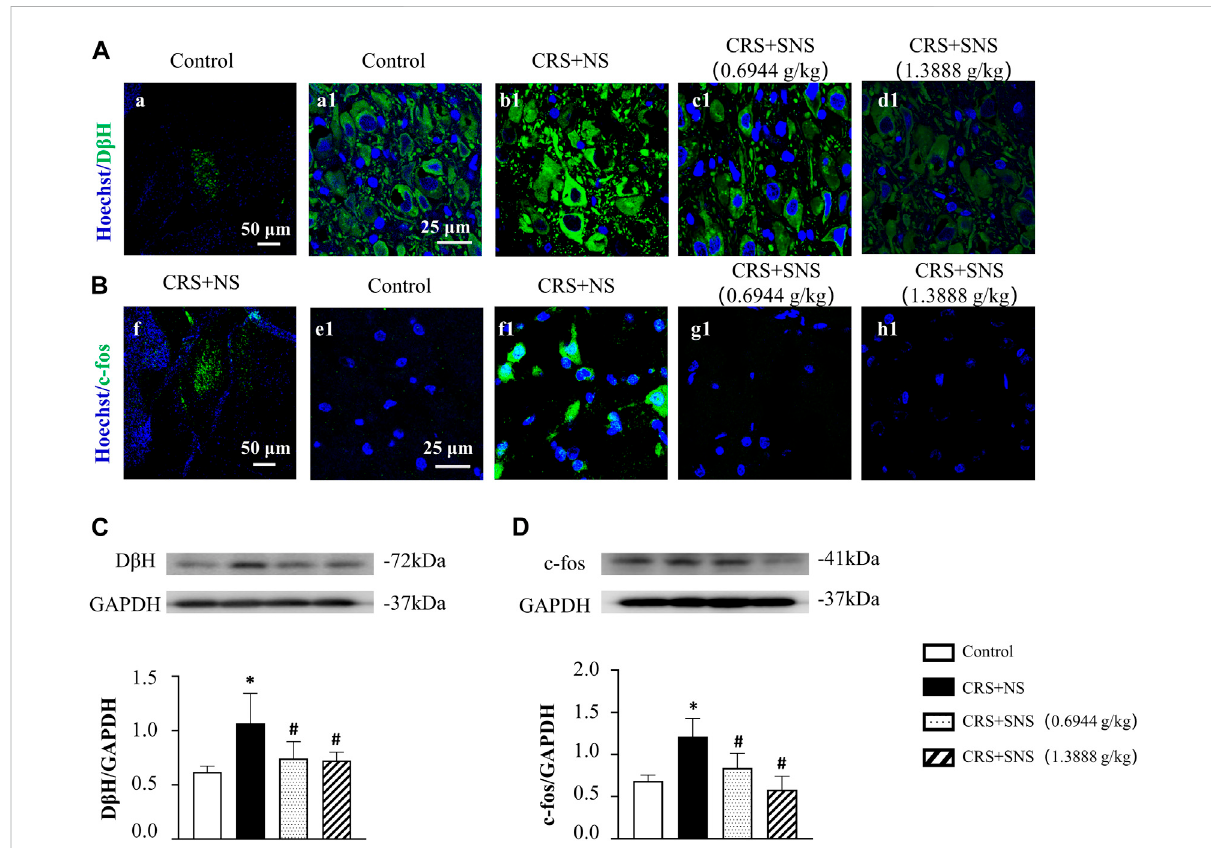
FIGURE 2 Effect of the SNS treatment on the expression of D β H and c-fos in locus coeruleus. (A) Representative immuno fl uorescent images of D β H (green)andnuclei(blue)intheControl(a1),CRS+NS(b1),CRS+SNS(0.6944 g/kg)(c1),andCRS+SNS(1.3888 g/kg)(d1)groups,respectively.Bar= 25 μ m. (A) istheimageofD β HintheControlgroupinalow-powerlens.Bar=50 μ m. (B) Representativeimmuno fl uorescentimagesofc-fos(green) and nuclei (blue) in the Control (e1), CRS + NS (f1), CRS + SNS (0.6944 g/kg) (g1), and CRS + SNS (1.3888 g/kg) (h1) groups, respectively. Bar = 25 μ m. (F) is the image of c-fos in the CRS + NS group in a low-power lens. Bar = 50 μ m. (C) Western blot of D β H in the locus coeruleus of different groups with quanti fi cation showing below. F = 6.178. p = 0.0054. (D) Western blot of c-fos in locus coeruleus of different groups with quanti fi cation showing below. F = 11.94. p = 0.0002. Results are presented as mean ± SEM. * p < 0.05 vs. Control group; # p < 0.05 vs. CRS + NS group. (A,B) n = 3. (C,D) n =